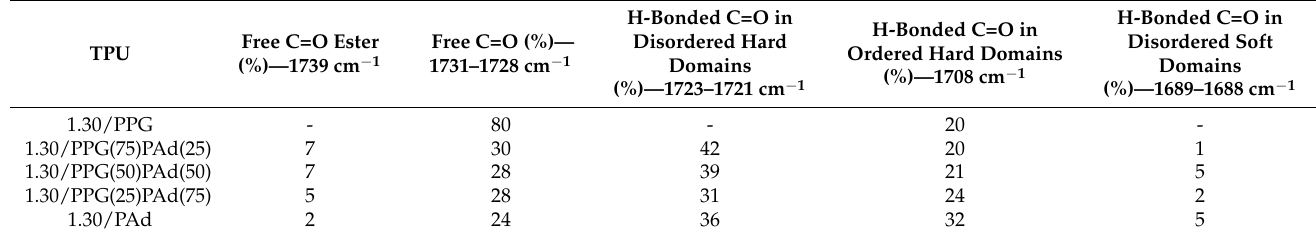
Table 2. Percentages of C=O species of the TPUs. Curve fitting of the carbonyl region of the ATR-IR spectra.